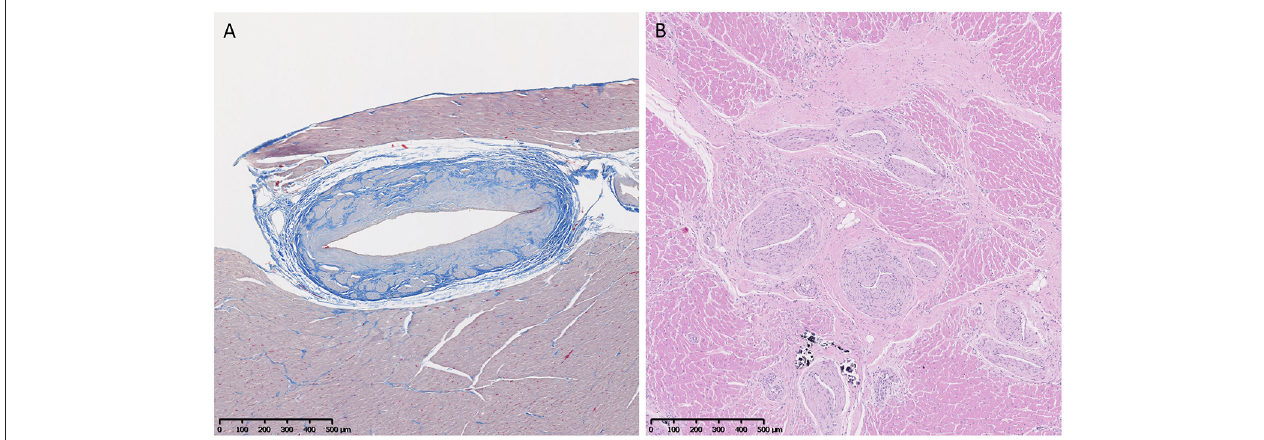
FIGURE 6 | (A) Increased fibrous tissue (blue) in an arteriole of a normal 3-year-old female. Trichrome, × 5 magnification. (B) Marked medial and intimal hypertrophy and vascular proliferation in arterioles in the heart of a 6-year-old male Golden Retriever muscular dystrophy dog. H&E, × 5